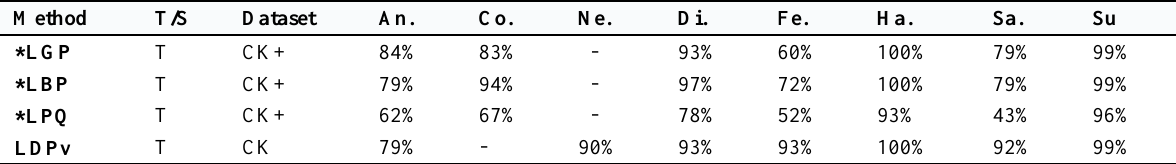
Table 6. Results comparison, using different methods on (CK+/CK) dataset with seven main facial expressions. S: